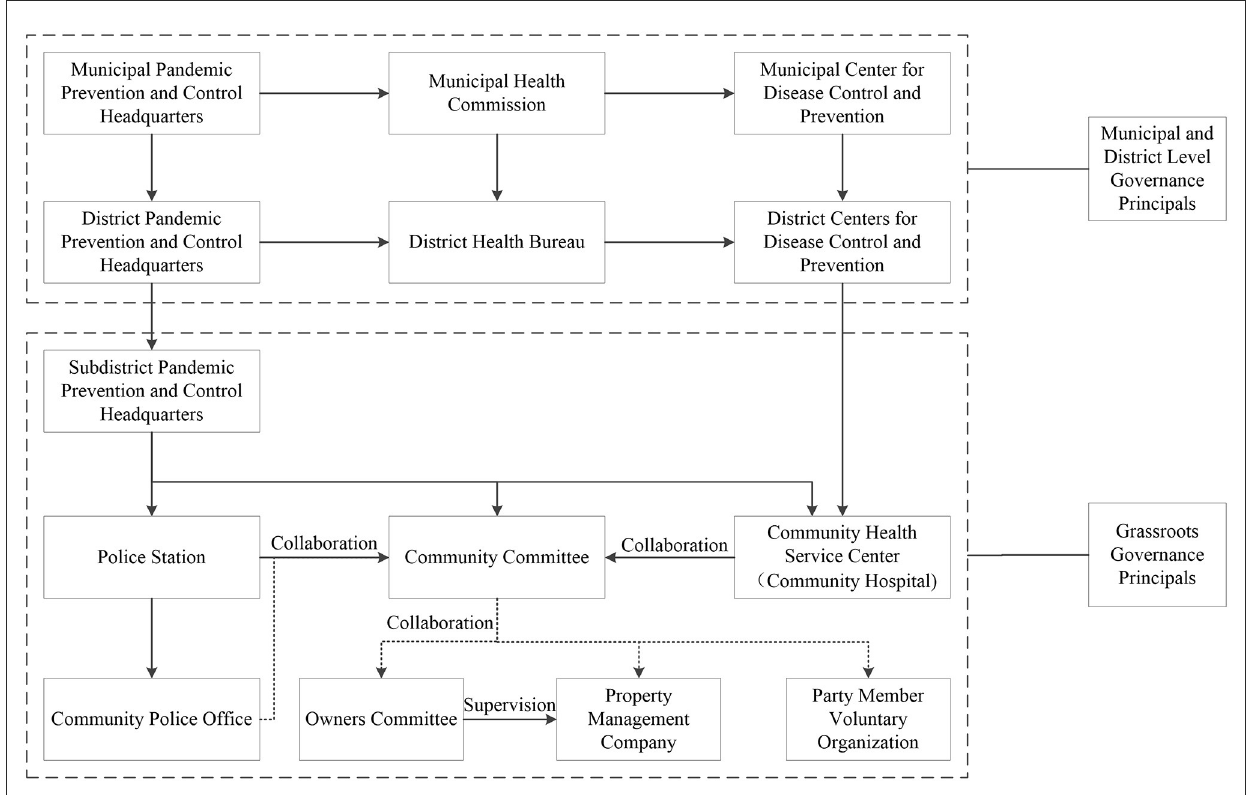
FIGURE1 Collaborative governance diagram of grassroots